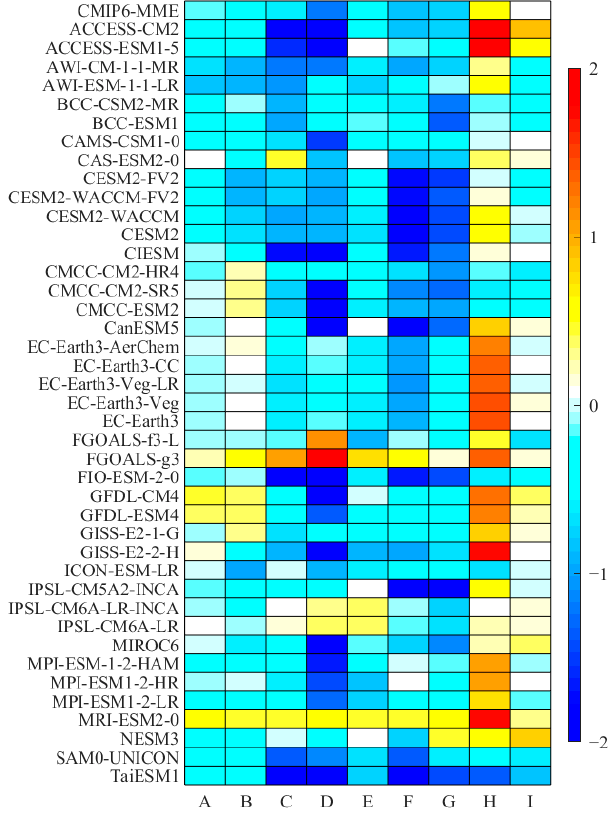
Figure 3. Model biases of area-averaged sea surface salinity in CMIP6 models compared with EN4 observations (unit: psu). The alphabetical order of A–I in the x-axis represents different Asian Marginal Seas that are marked by boxes in Figure 1. A. Bering Sea; B. Sea of Okhotsk; C. Japan/East Sea; D. East China Seas (including the East China Sea, the Yellow Sea, and the Bohai Sea, ECSs); E. Philippine Sea; F. South China Sea (SCS); G. Indonesian Seas; H. Bay of Bengal; and I. Arabian Sea. The TD scores for the AMSs’ SSS, with smaller values indicating better simulation skills, are displayed in Figure 5. The CMIP6 MMEs show better results than most CMIP6 models by averaging the errors/biases, with scores of 0.47, ranking at fourth place (Figure 5). The BCC-series models, which include BCC-CSM2-MR and BCC-ESM1, obtained the “best” AMSs’ SSS simulation, with TD scores of 0.33 and 0.39, respectively, ranking at first and of 0.47, ranking at third place, with a slightly better SSS simulation than CMIP6 MME (Figure 5). The IPSL-CM5A-INCA ranks last, with TD scores of 1.89, preceded by the ACCESS-CM2 and ACCESS-ESM1-5, with TD scores of 1.86 and 1.51, respectively, ranking second and third to last (Figure